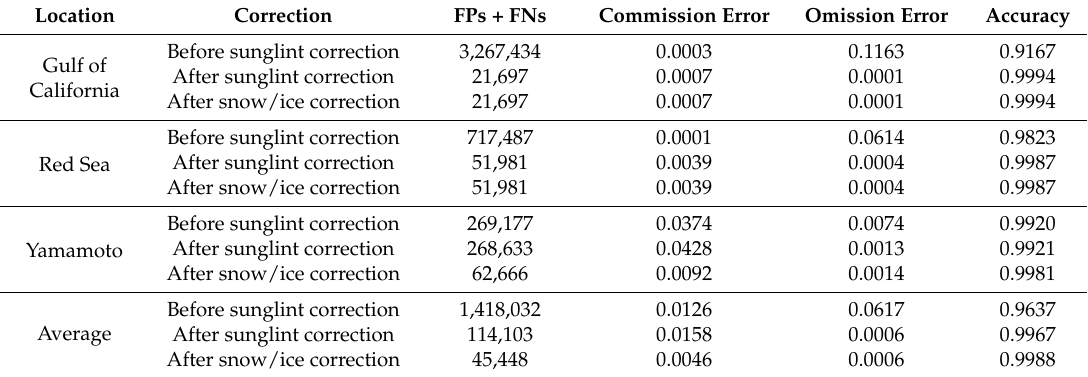
Table 6. Quantitative evaluation of the performance of the proposed method and improvements after sunglint and snow/ice